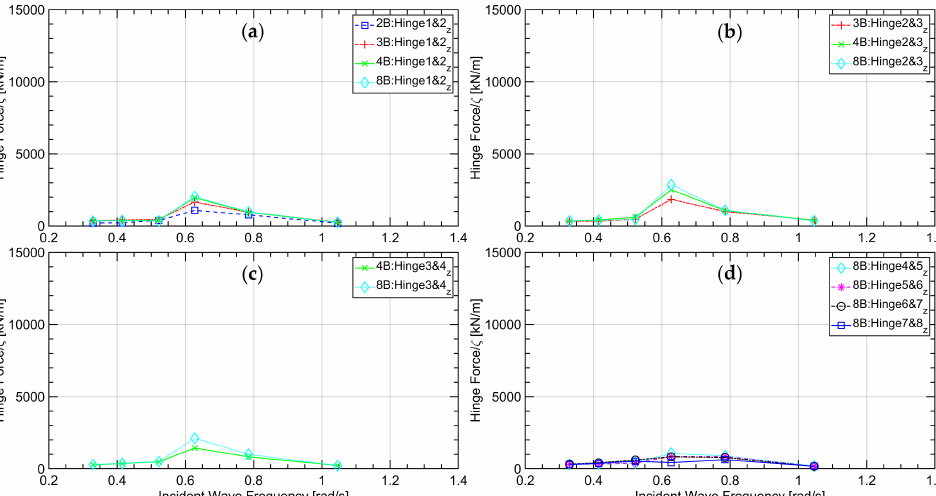
Figure 13. First-order hinge forces in vertical direction of the five test cases for the chain configuration, where n B denotes the configuration with n bodies; m & n , the hinge connecting m -th body and n -th body; subscript z , the hinged forces in z direction: ( a ) between 1st and 2nd modules; ( b ) between 2nd and 3rd modules; ( c ) between 3rd and 4th modules; ( d ) between 4th and 5th , 5th and 6th , 6th and 7th , 7th and 8th modules.